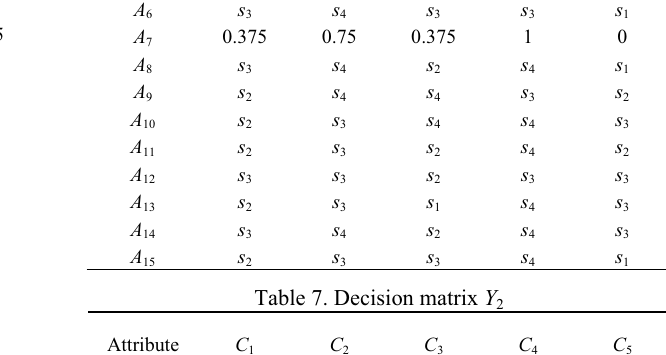
Table 7. Decision matrix Y 2